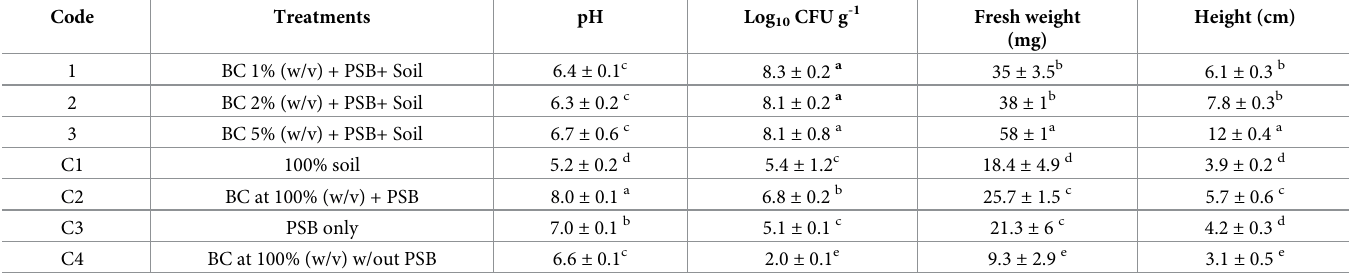
Table 3. Biochar and soil effect on Allium cepa growth. Greenhouse results of Allium cepa seed growth for five weeks under greenhouse conditions with different bio- char concentrations and soil.